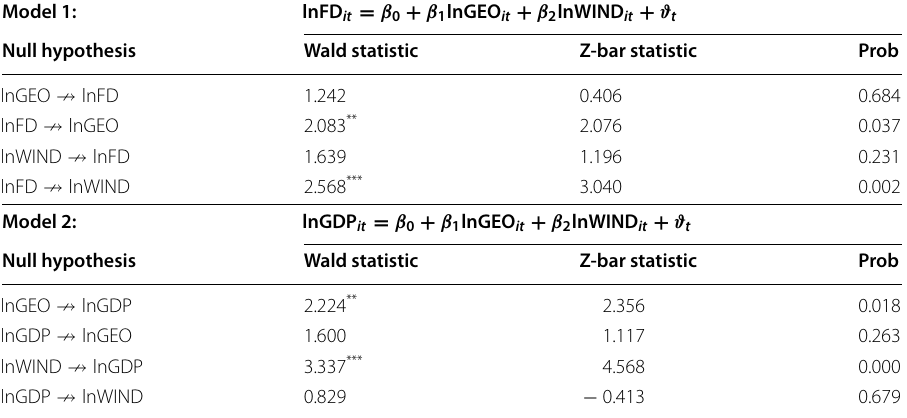
Maximum lag length is determined as 1. ***, **, and * denote significance at 1%, 5%, and 10% significance levels, respectively